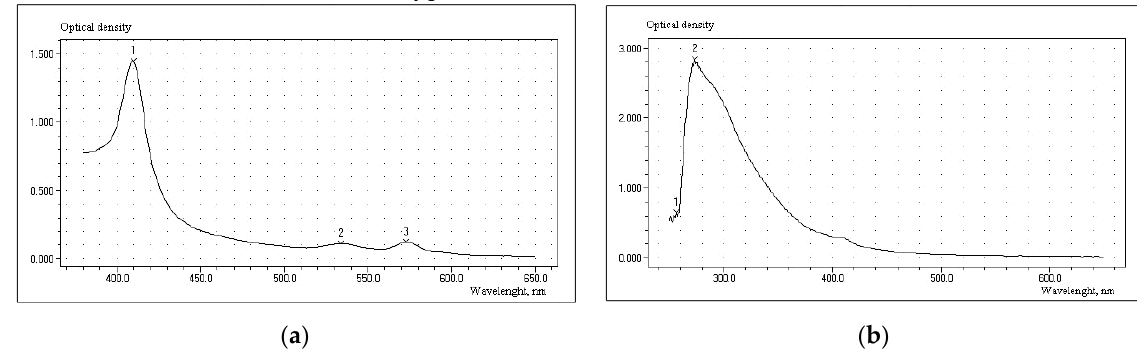
Figure 2. Absorption spectra of DMF extracts of the resins of HO nos. 1 ( а ) and 2 ( b ).